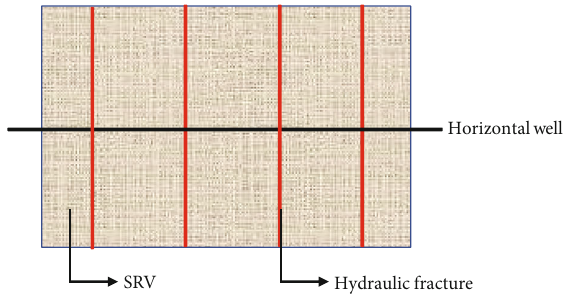
Figure 2: Schematic diagram of the simpli fi ed model.